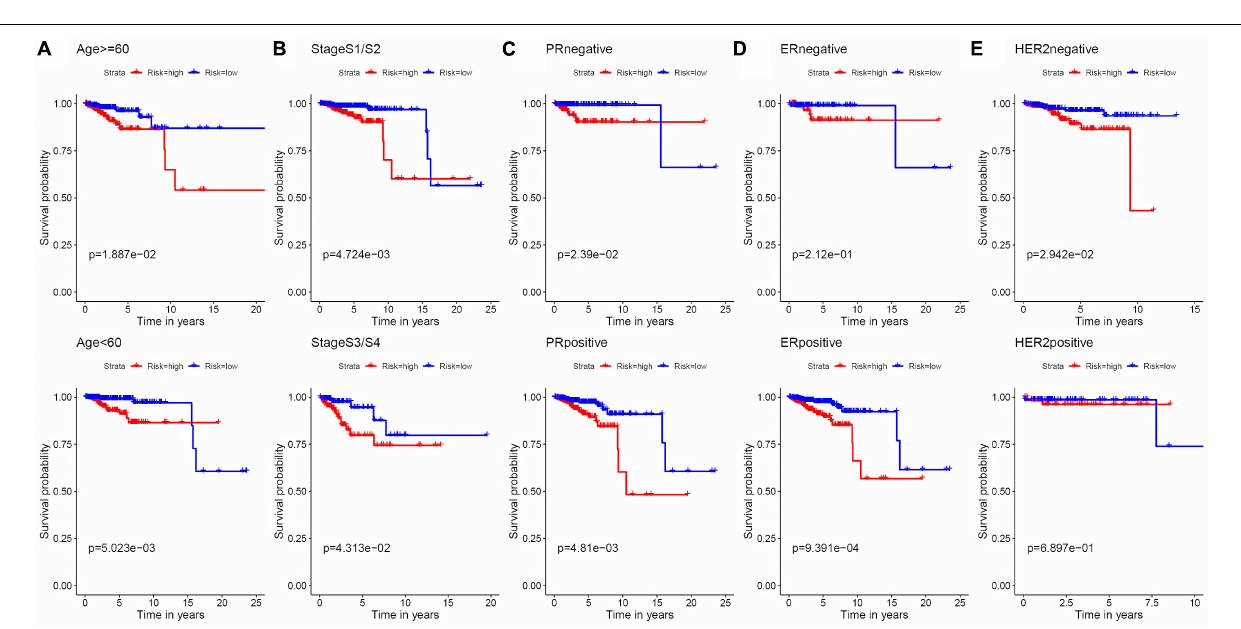
FIGURE 4 | Kaplan–Meier survival analysis of the 3-APA-event risk score level for OS in different subgroups. (A) Age < 60, Age ≥ 60. (B) Stage 1/2, Stage 3/4. (C) PR negative, PR positive. (D) ER negative, ER positive. (E) HER2 negative, HER2 positive.